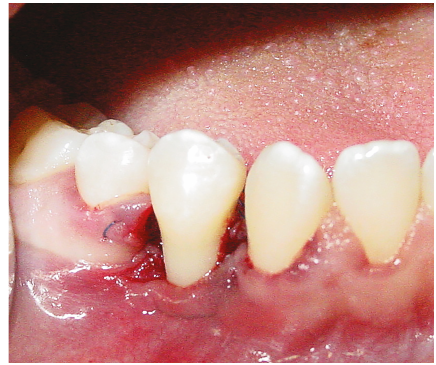
Figure 7: Immediate postoperative aspect.